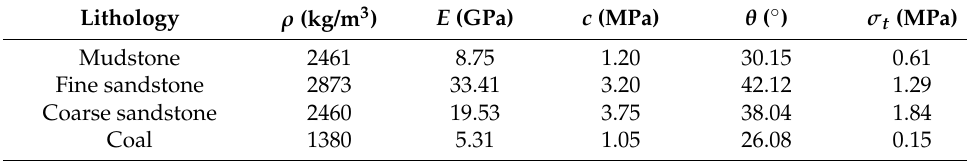
Table 1. Mechanical parameters of coal and rock.